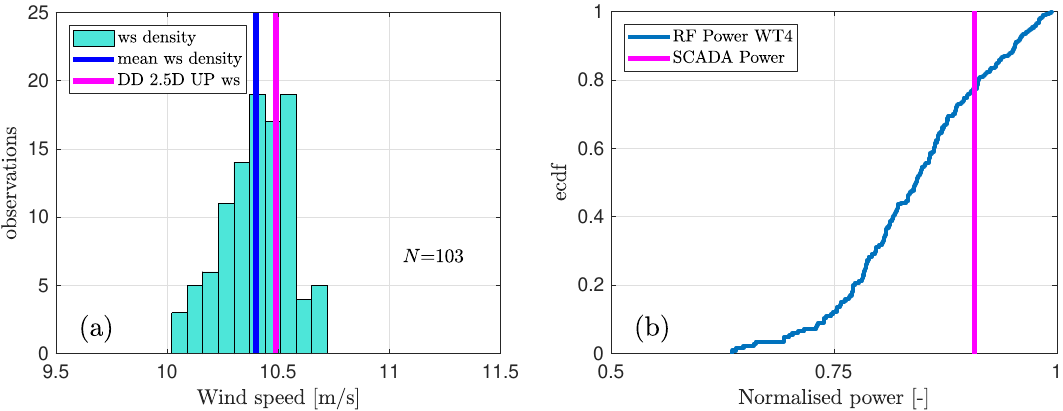
Figure 7. ( a ) predictive histogram distribution of wind speeds for WT 4 at the time shown in Figure 5b. The blue line represents the mean of the distribution and the magenta line the verifying dual-Doppler wind speed 2.5 D upstream of the rotor. N indicates the number of wind field vectors; ( b ) predictive empirical cumulative distribution function of the normalised power for WT 4 at the same time. The magenta line indicates the observed